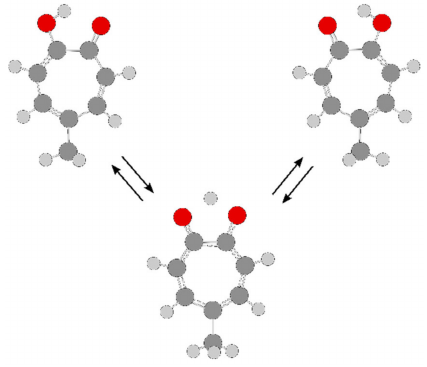
Figure 23. The coupled large amplitude motions of 5-methyltropolone. The two equivalent equilib- rium conformations shown in the upper trace can be converted into each other over a transition state shown in the lower trace through a hydrogen-transfer tunneling path. This induces a “corrective internal rotation” [215] of 60 ◦ for the methyl